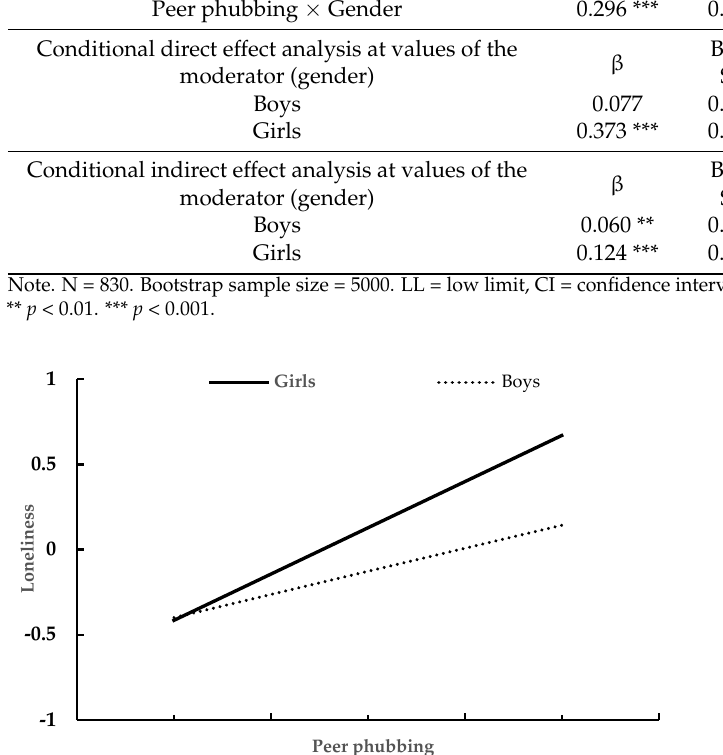
Figure 1. The relationship between peer phubbing and loneliness in girls and boys.